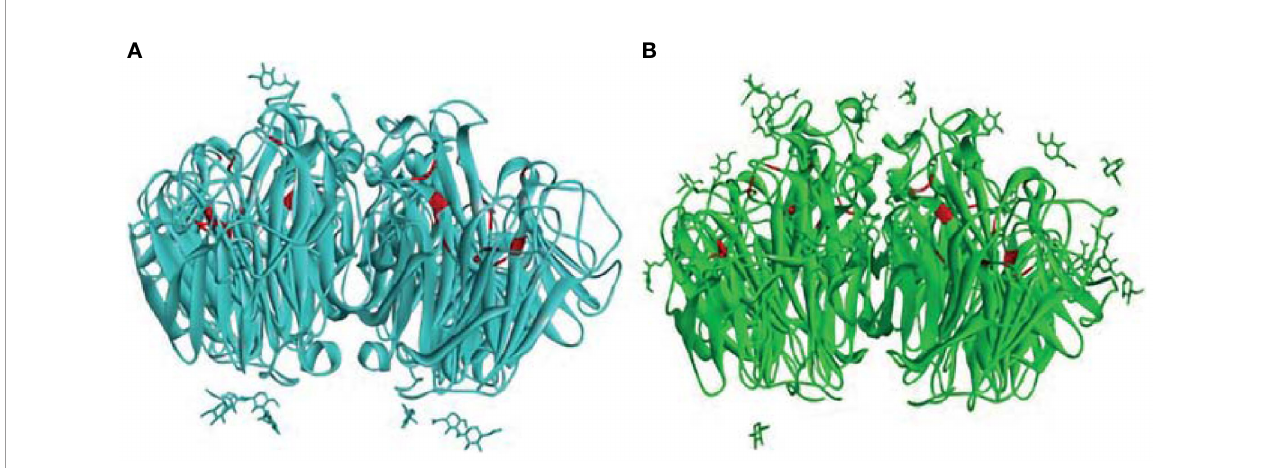
FIGURE 10 | Comparison of the glycosylation patterns as observed in the crystal structures of (A) H1N1 NA (PDB ID: 6Q23) and (B) H3N2 NA (PDB ID: 4GZX) receptors. The sialic acid binding site residues ARG118, ASP151, ARG152, ARG224, GLU276, ARG292, ARG371, TYR406 (48) in the two NAs are depicted in